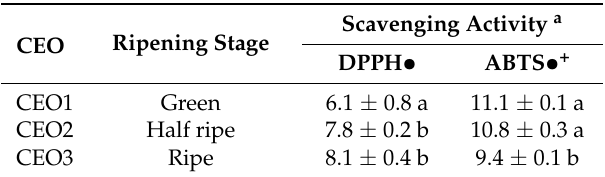
Table 2. Radical scavenging activities of